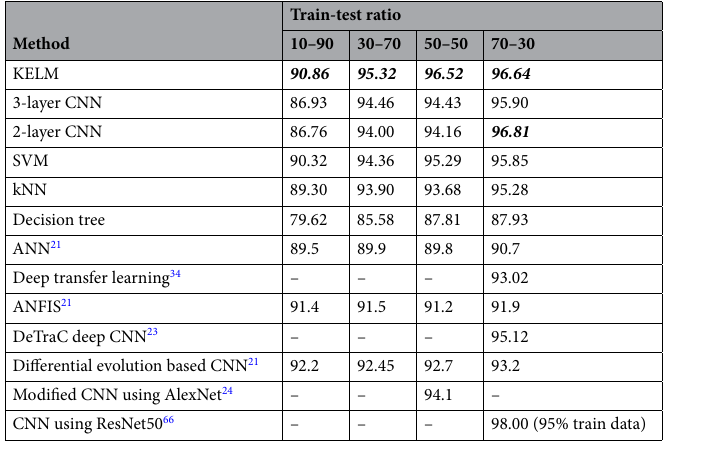
Table 6. Comparison of the classifiers with other state-of-art approaches based on accuracy (%). Significant values are in bolditalic.